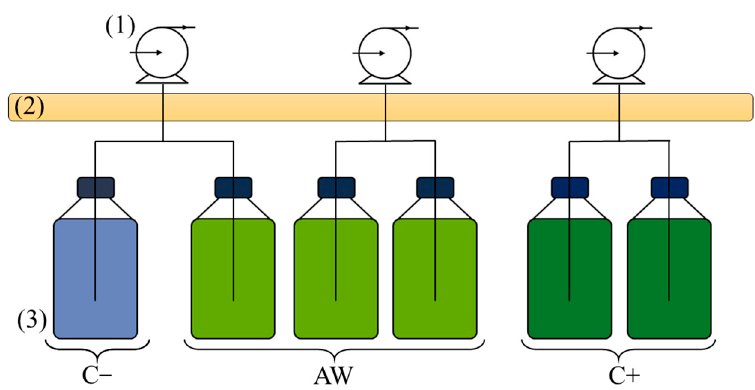
Figure 1. Schematic diagram of the experimental setup: (1) air pumps; (2) light-emitting diode (LED) panel; and (3) culture flasks.